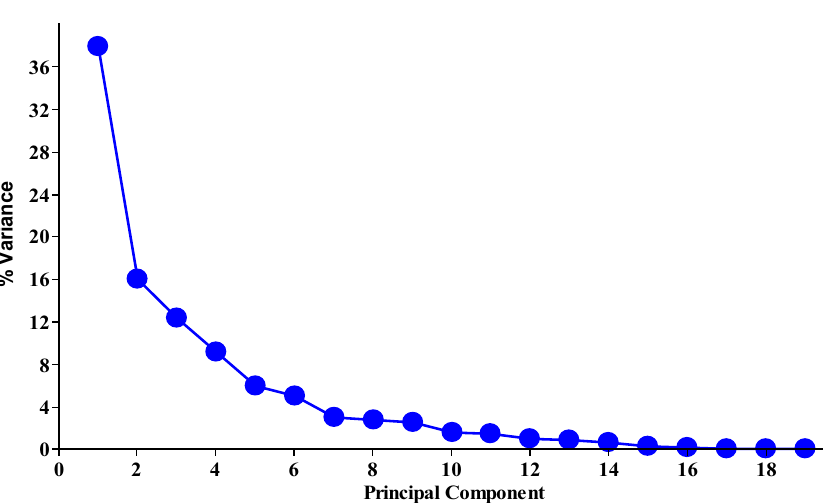
Fig. 6 Plot in between (%) variance and the principal com- ponents of the physico-chemical components of the